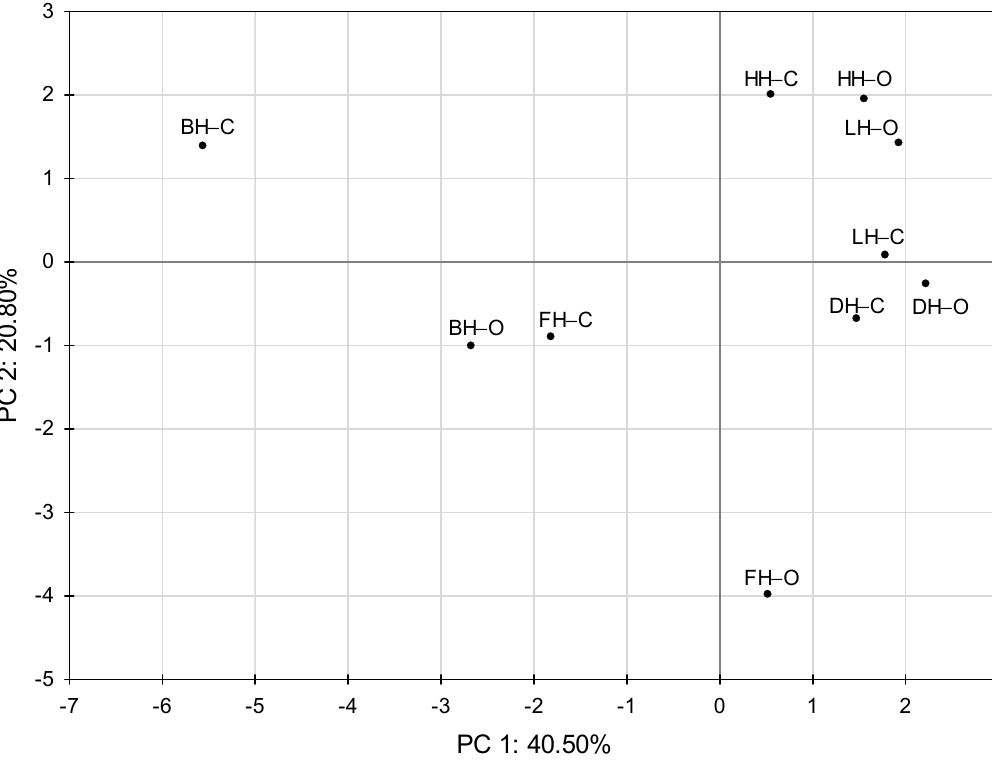
Figure 2. PCA score plot showing differentiation of tested honey samples. Abbreviations of honey samples are explained in Table 7. HH—honeydew honey, FH—forest honey, BH—buckwheat honey, LH—linden honey, DH—dandelion honey, C—conventional production method, O—organic production method.